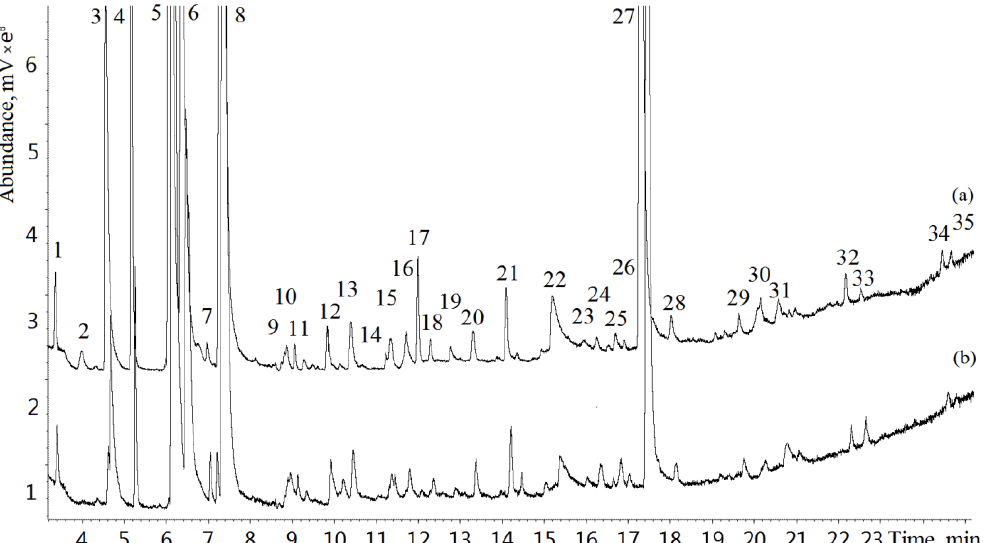
Figure 1. Typical total ion current (TIC) chromatograms of a lung cancer patient (a) and a healthy